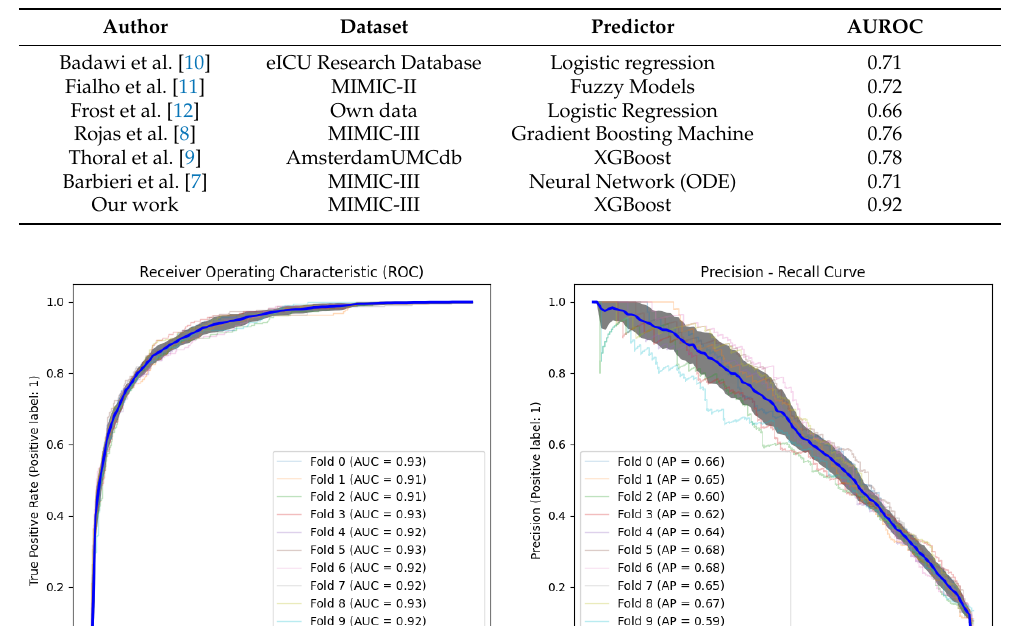
Table 6. Comparison with related works in terms of AUROC.